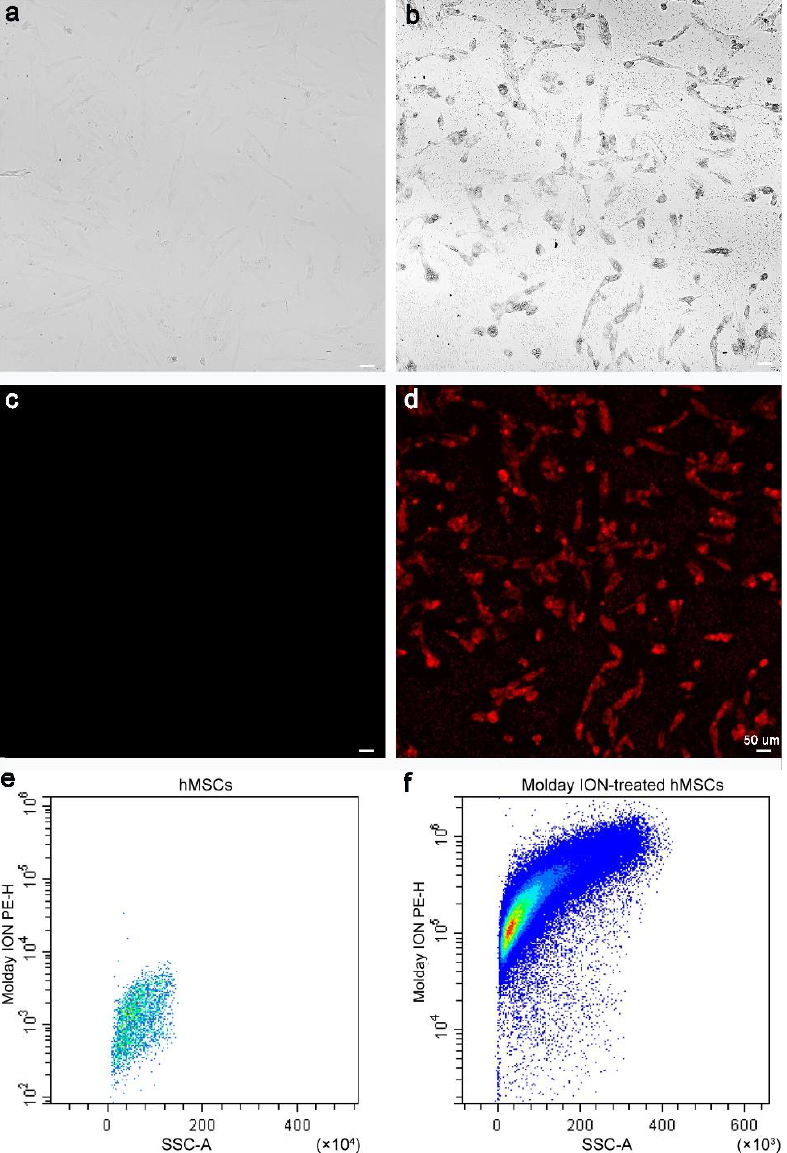
Figure 1. Microscopic and flow cytometry analysis of labeled hMSCs: Bright-field images of non- labeled ( a ) and Molday ION-treated hMSCs ( b ), fluorescent microscopy also of non-labeled ( c ) and Molday ION-treated hMSCs ( d ), and flow cytometry analysis of hMSCs of non-labeled ( e ) and Molday ION-treated hMSCs ( f ) .